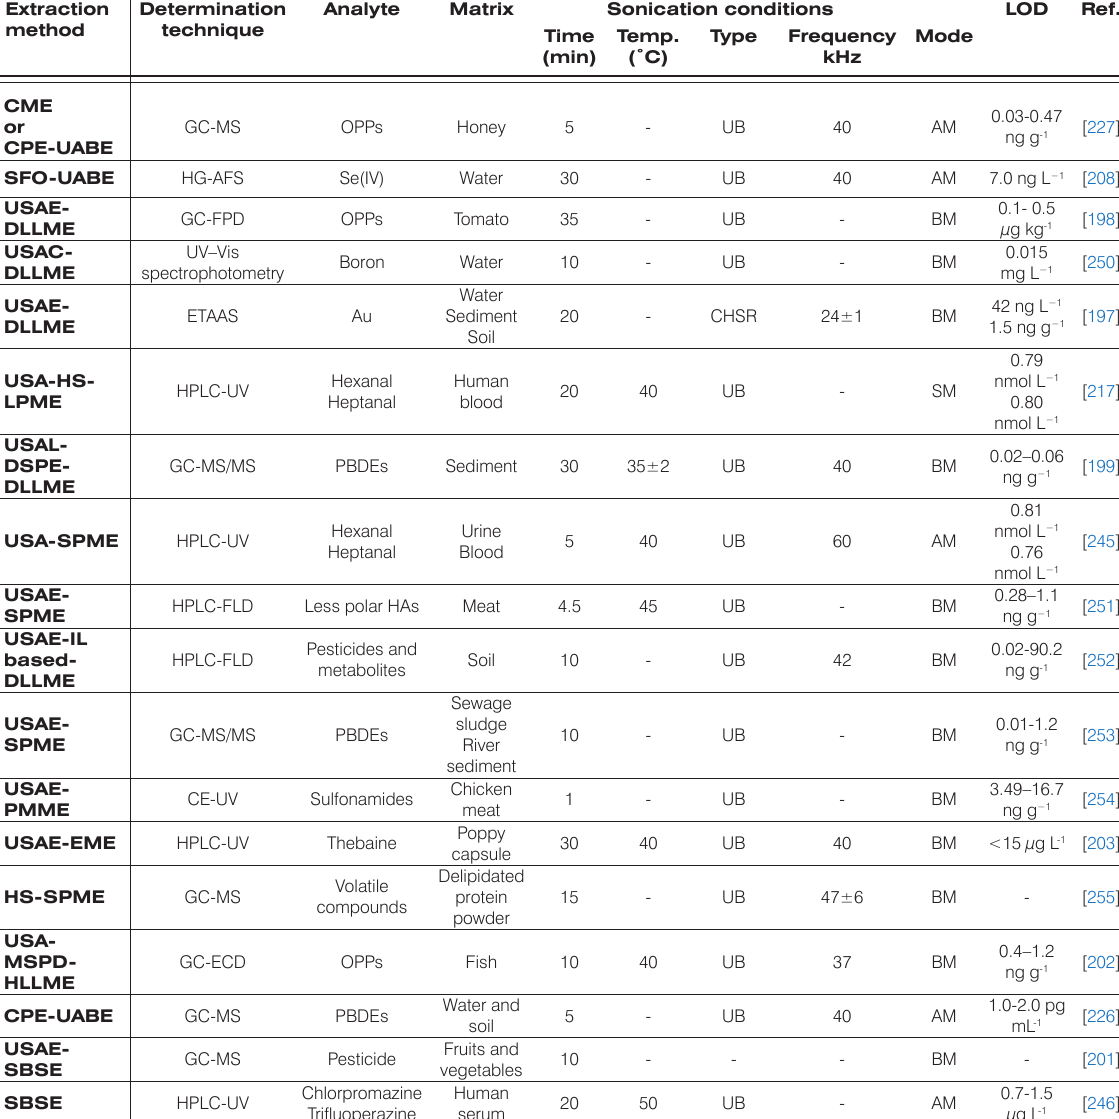
Table 5. Different ultrasound assisted microextraction techniques (Before and after sonication modes, BM and AM) for determination of organic and inorganic compounds from different matrices. Extraction